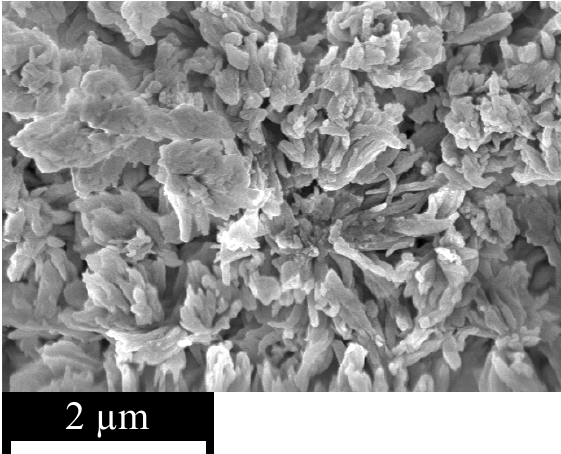
Figure 1. SEM micrograph of EOF-5 shows very heterogeneous particle size and shape distribution. Micrographs of EOF-3 and -4 are not shown but look